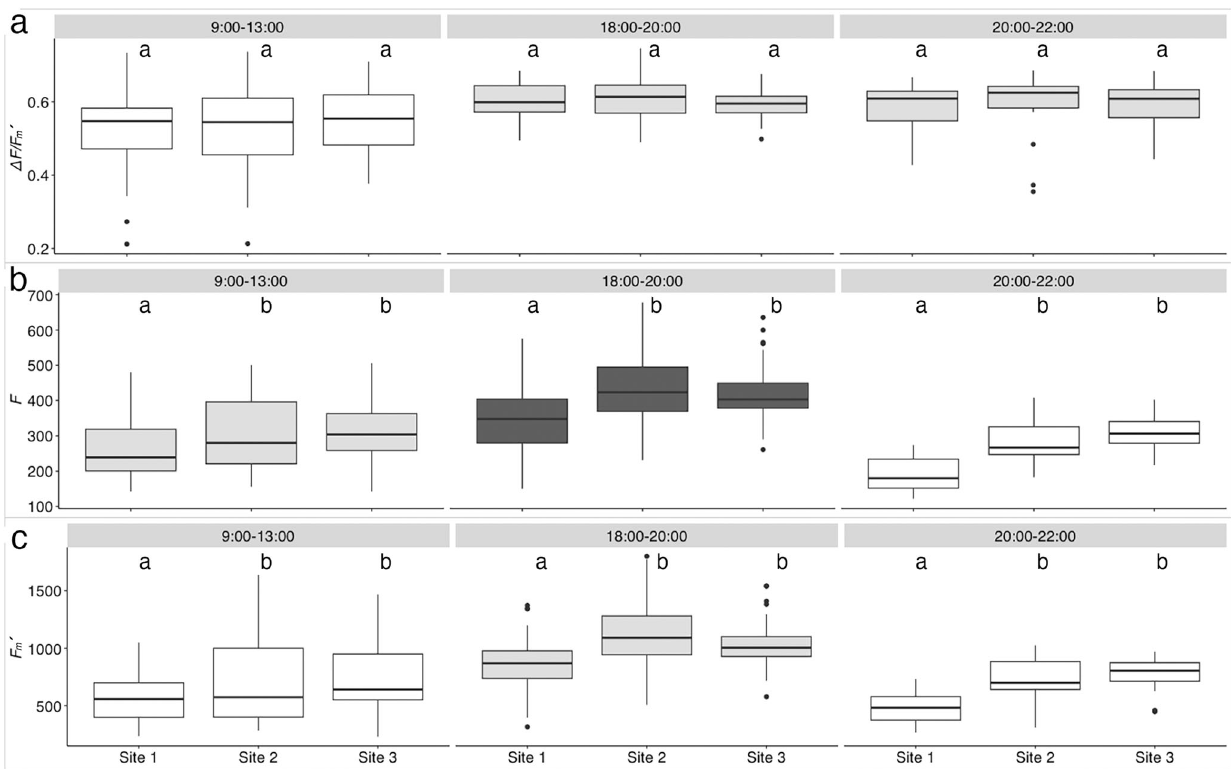
Fig. 2 Boxplots of fl uorescence parameters obtained by PAM measurements at the three Sites and at three time intervals. a Effective quantum yield ( Δ F/F m ´ ), b minimum fl uorescence ( F ), and c maximum fl uorescence ( F m ´ ). For each parameter, signi fi cant differences ( p < 0.01) between time intervals are indicated by different colors (signi fi cantly higher mean value is ranked as white->light gray->dark grey). The boxes indicate the 25 th and 75 th percentiles and the line within the boxes mark the medians. Whisker length is equal to 1.5 × interquartile range (IQR). Circles represent outliers. Different letters indicate statistical differences ( p < 0.05; number of specimens measured is reported in Supplementary Table